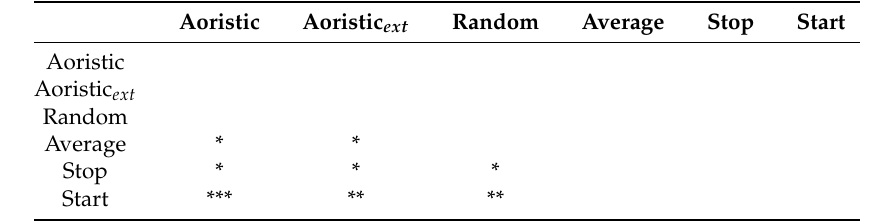
Table 5. Dunn significance test results from pair-wise comparisons between temporal analysis methods over the χ 2 hour data.